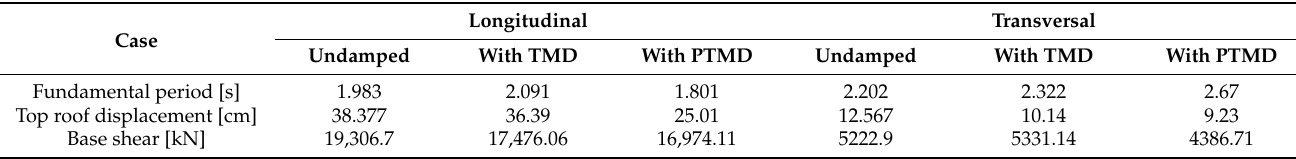
Table 7. Response of the high-rise building for the TMD and PTMD configuration.